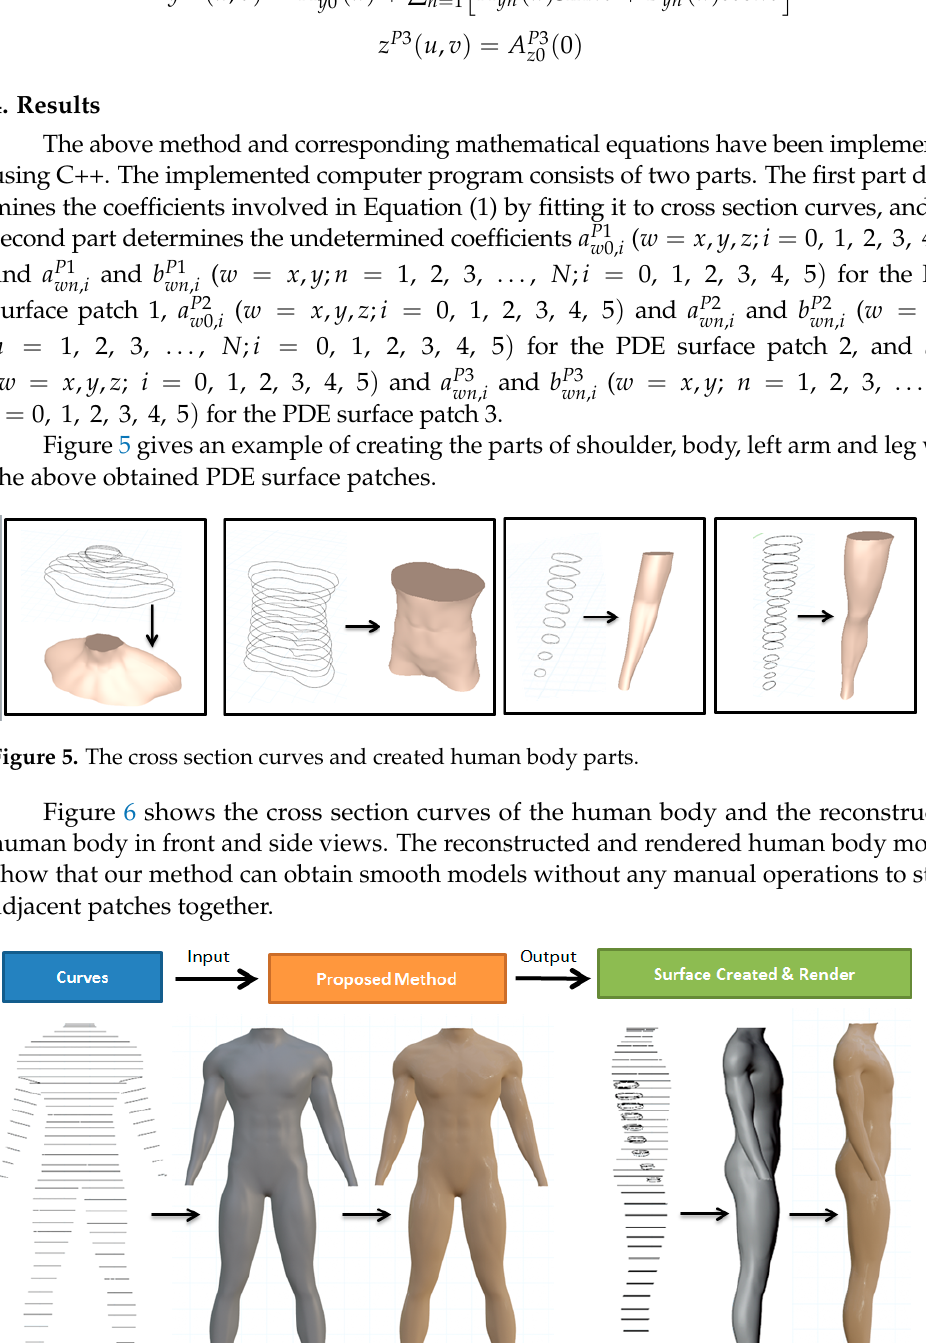
Figure 6. The cross section curves of the human body and the created human body model in front and side views using 𝐶 (cid:2870) continues PDE method.